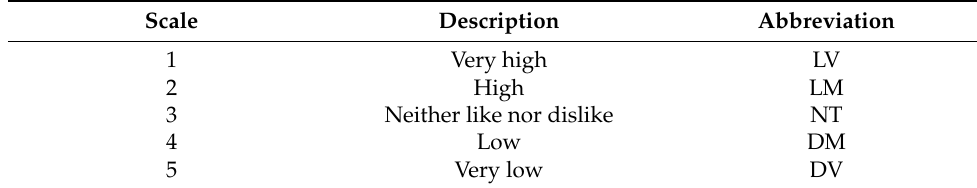
Table 2. Criteria importance level